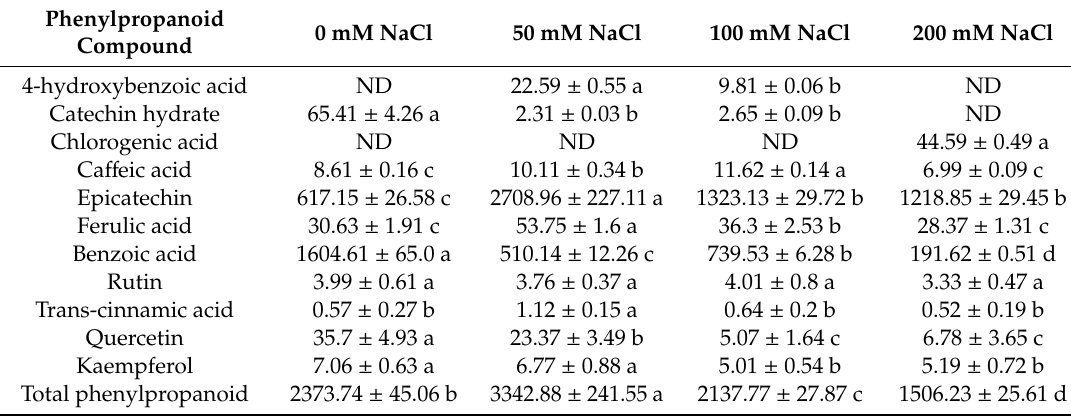
Table 2. The phenylpropanoid content ( µ g g − 1 dry weight) under di ff erent NaCl concentrations. ND, not detected. Each result was calculated from three biological replicates. Letters a-d denote significant di ff erences ( P <